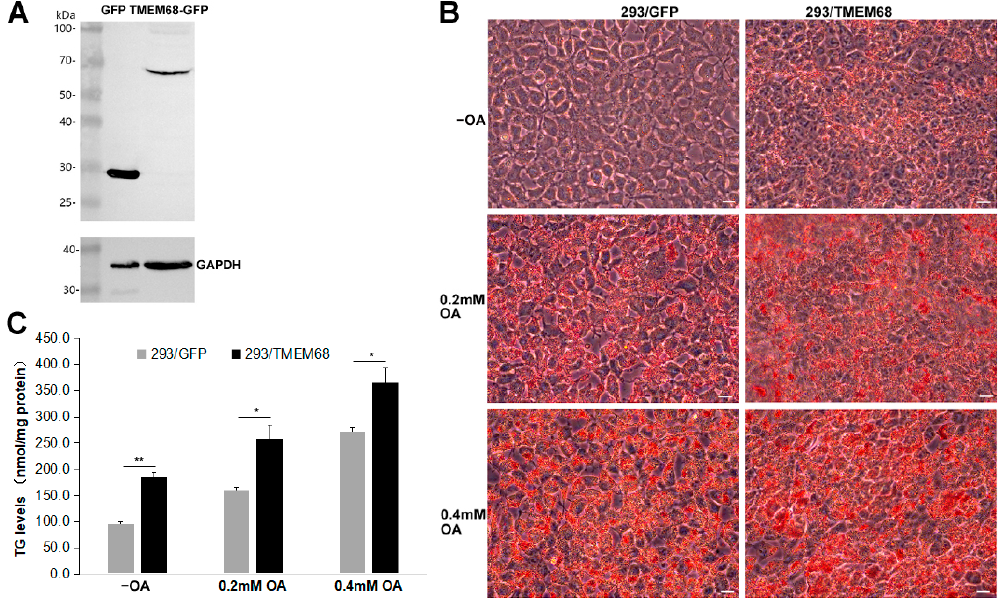
Figure 1. Overexpression of TMEM68 promotes TG accumulation. ( A ) The expression of GFP and TMEM68-GFP was detected by western blotting using an anti-GFP antibody in HEK293 cells that stably expressed GFP (293/GFP) and TMEM68-GFP (293/TMEM68), respectively. The expression of GAPDH was detected as loading control. Migration of molecular mass standard proteins is indicated left of the figure. ( B ) 293/GFP and 293/TMEM68 cells were loaded with 0.2 mM, 0.4 mM OA or not ( − OA) for 12 h and then fixed LDs and subjected to ORO staining. Cell images were captured by using an Olympus IX53 inverted microscope. Images were representative of at least three experiments. Scale bars, 10 μ m. ( C ) TG levels were quantified in 293/GFP and 293/TMEM68 cells in the presence or absence of 0.2 mM or 0.4 mM OA for 12 h. Data is presented as means ± SD. Asterisk indicates p values: * p < 0.05, ** p < 0.01, n = 4.